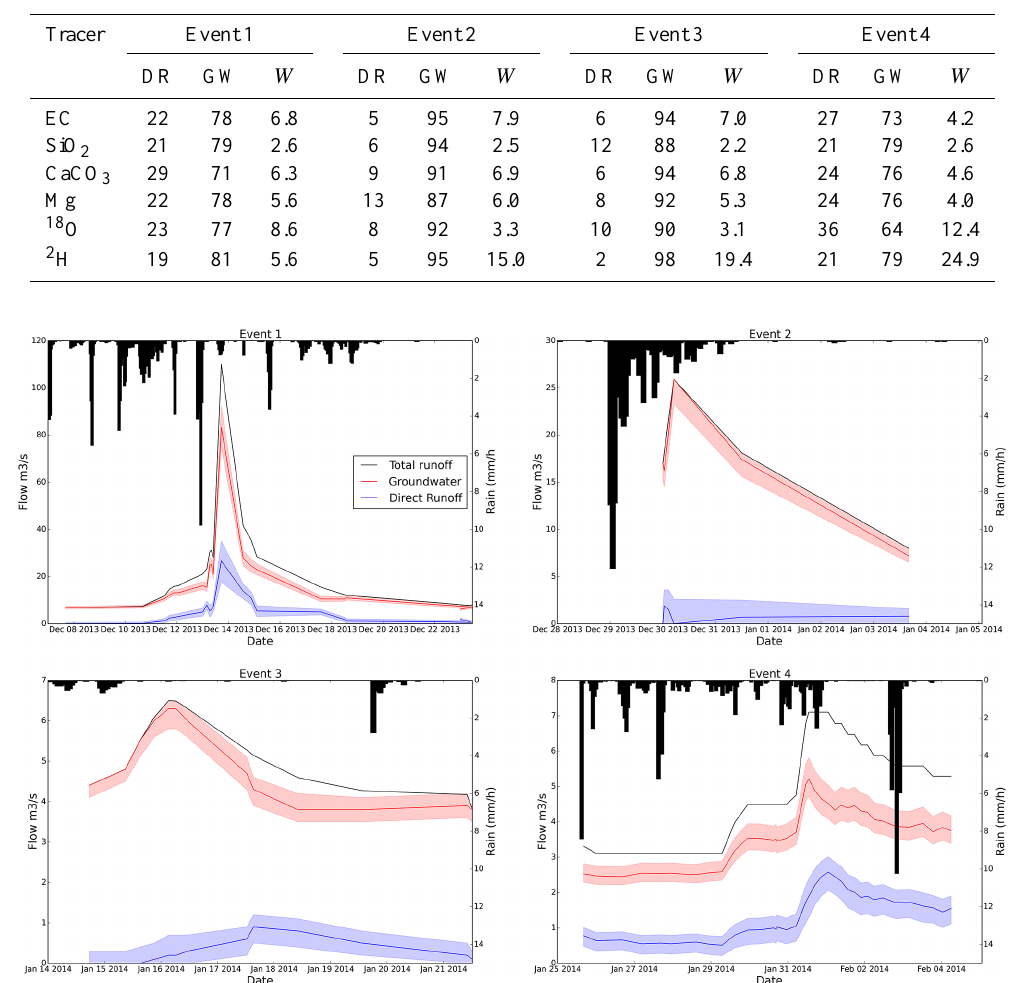
Figure 8. Two-component hydrograph separations using electrical conductivity as a tracer. Events 1 and 4 had a larger direct runoff contri- bution coinciding with the total runoff peak. Events 2 and 3 had a smaller direct runoff